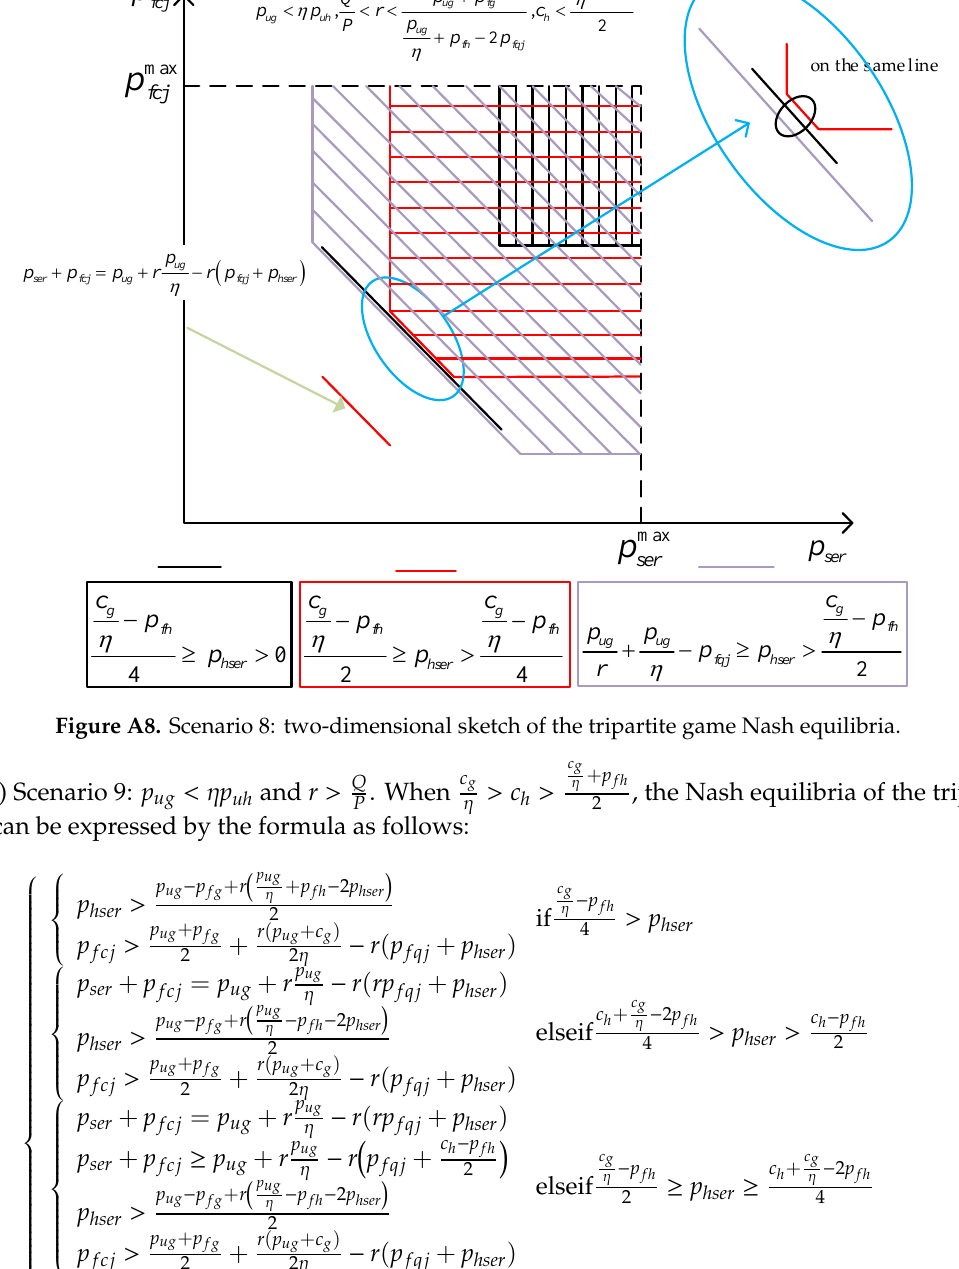
p ug > − p ≥ p + p ug η fqj hser r